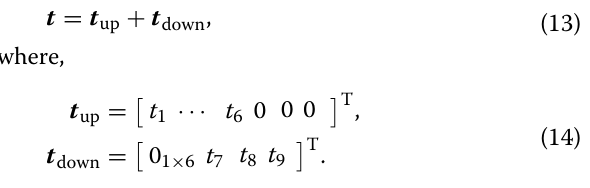
Figure 8 Layout of linear scales and wire